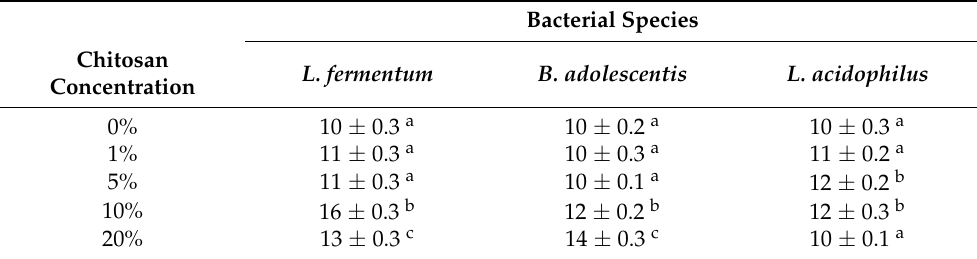
Table 1. Inhibition of pathogenic bacteria growth by probiotic bacteria supernatant derived from the growth of probiotic in chitosan-supplemented media.